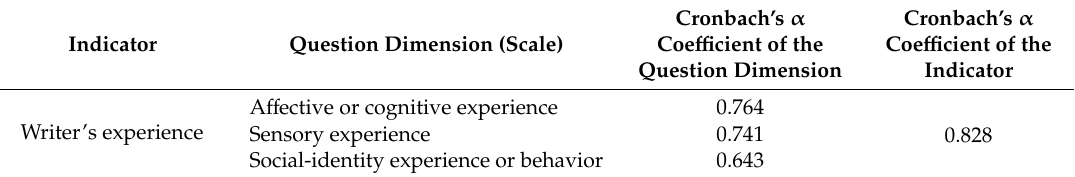
Table A8. Cronbach’s α coe ffi cients of the three question dimensions of the indicator “writer’s experience” of the collected questionnaire